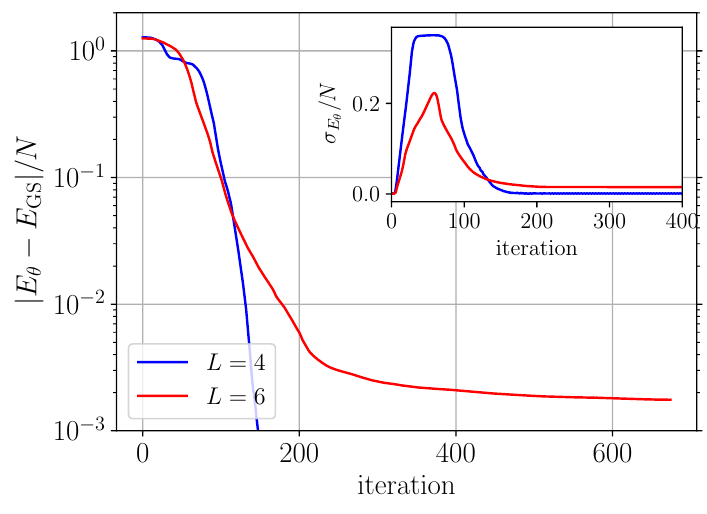
Figure 10: Energy minimization in the full-basis simulation learning problem for N = 4 × 4 (blue) and N = 6 × 6 (red). Albeit faster, for N = 6 × 6, we obtain similar energies as with MC sampling which implies that the problem with reaching the cor- rect ground state is not (directly) related to MC sampling. The network architecture / J = 0.5. Optimization was done using RK in combination is listed in App. H, and J 2 1 with SR, see App.